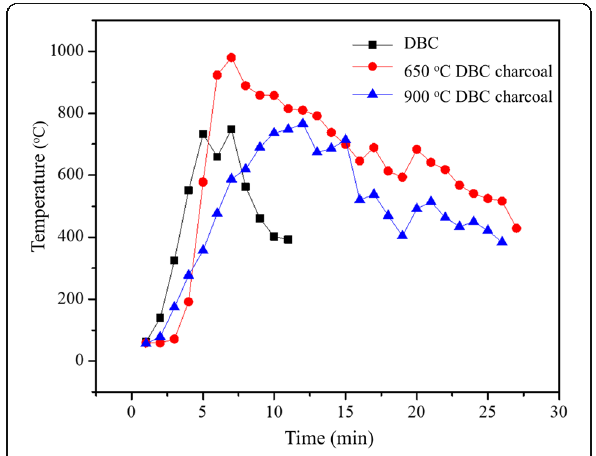
Fig. 3 Comparison of cooking stove ’ s flame temperature